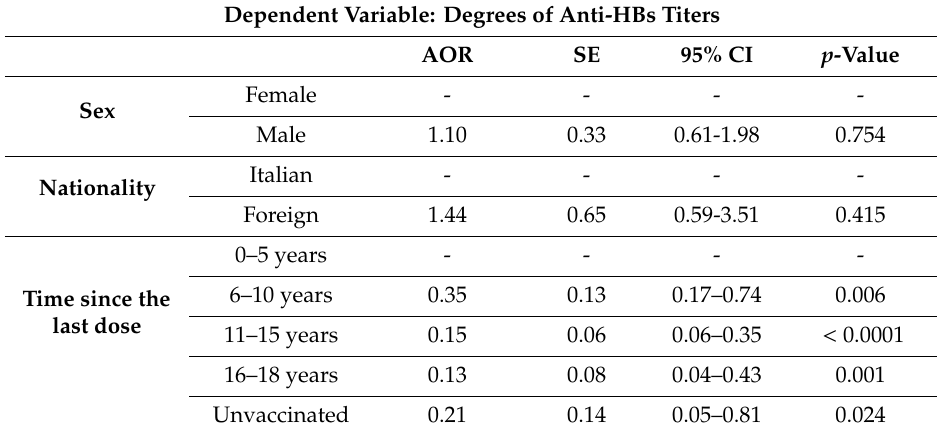
Table 4. Multivariate ordinal logistic regression